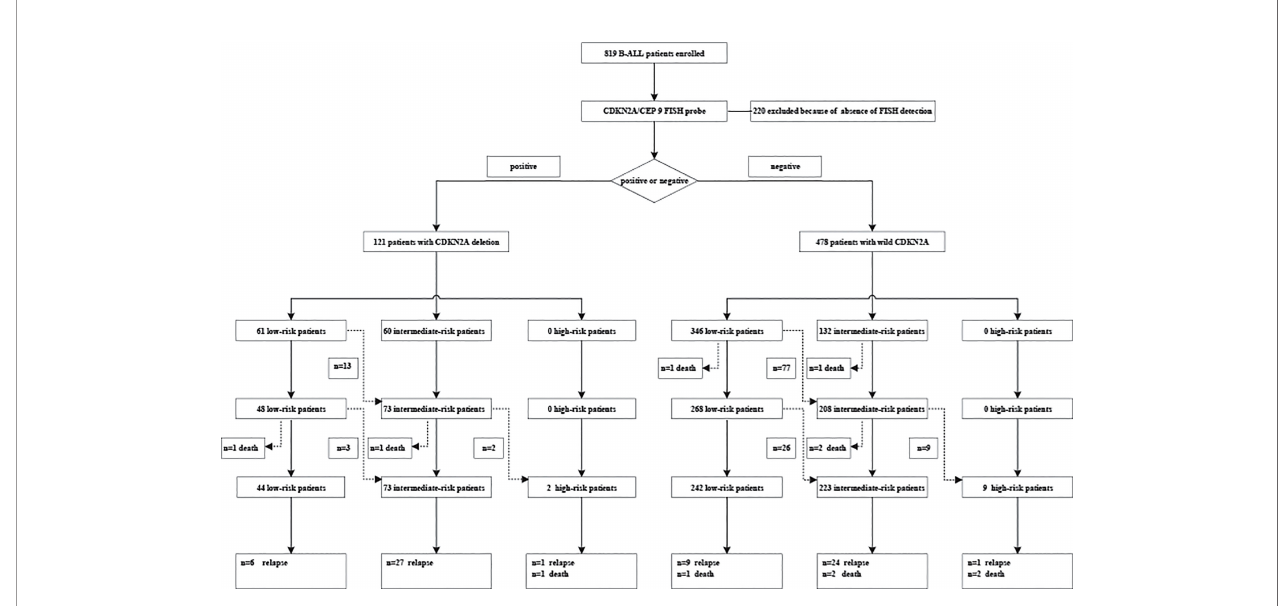
FIGURE 1 | Clinical pro fi